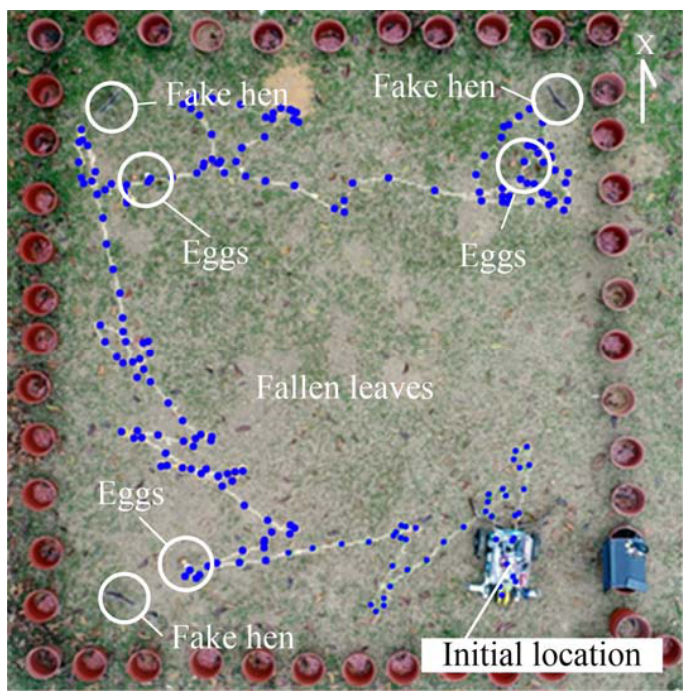
Figure 14. Navigation trajectory for the robot using the GNSS ‐ RTK positioning method.